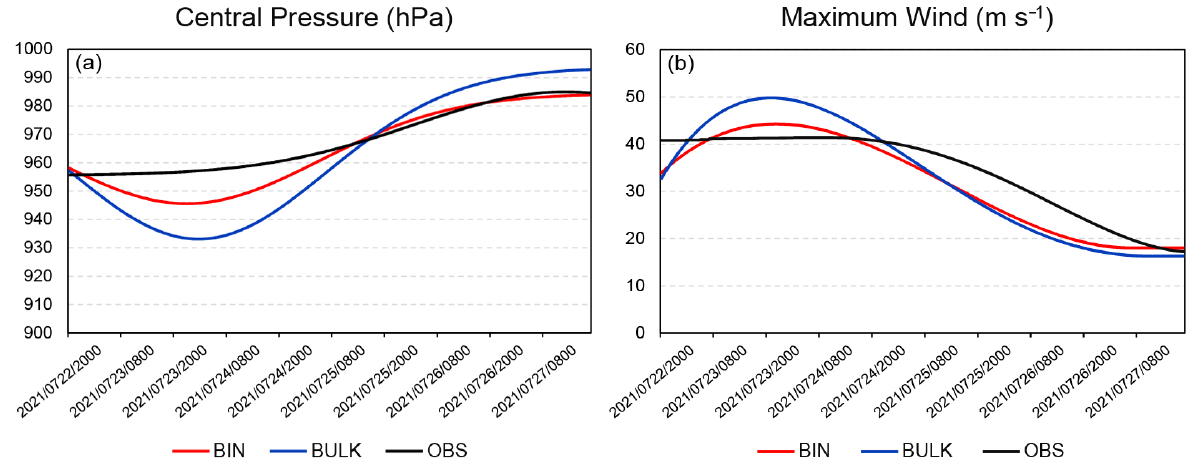
Figure 2. Temporal evolution of ( a ) minimum central pressure (hPa) and ( b ) maximum surface wind (m s −1 ).